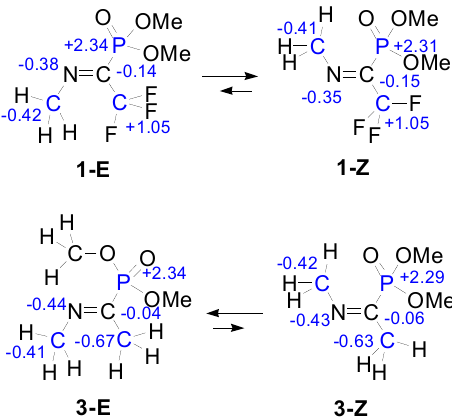
Figure 5. Charges on the atoms in compounds 1 and 3, calculated by the NBO method.